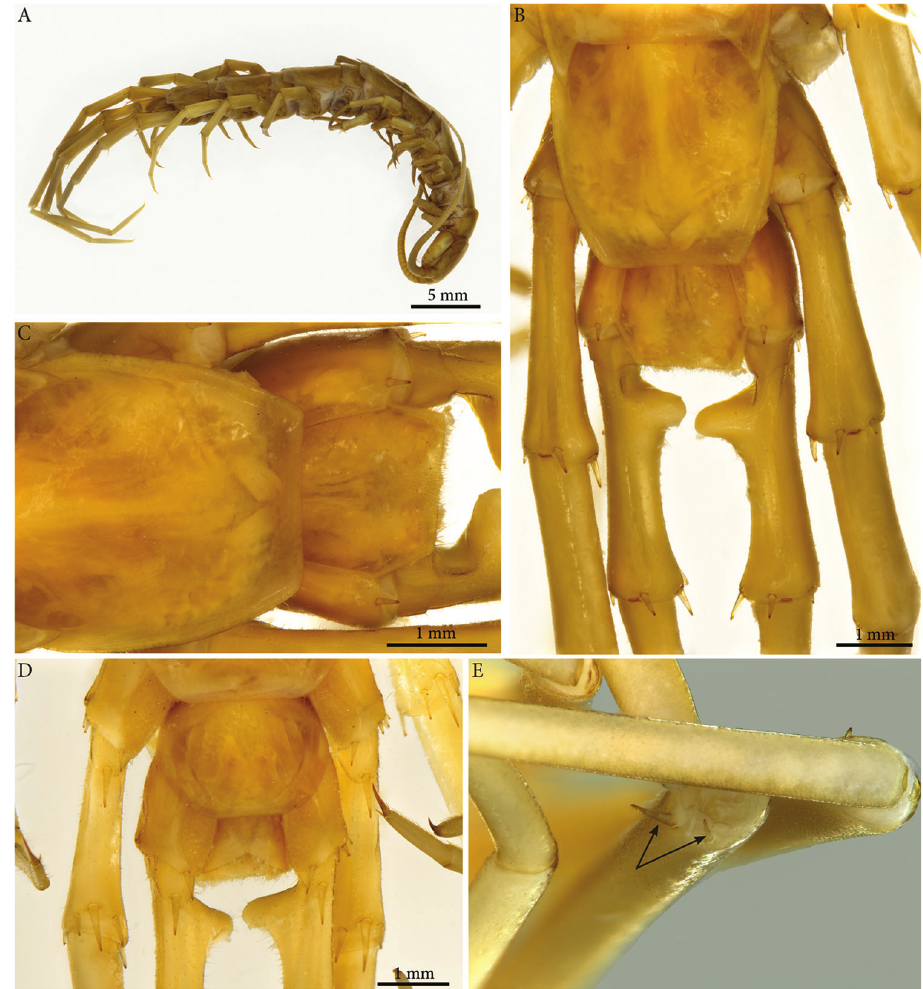
Figure 9. E. wardaranus , male syntype. A Habitus B Terminal part, dorsal view C TT14-15, dorsal view D Sternites 14-15, ventral view E Tibia of leg 15. Arrows pointing to the ventral spines.